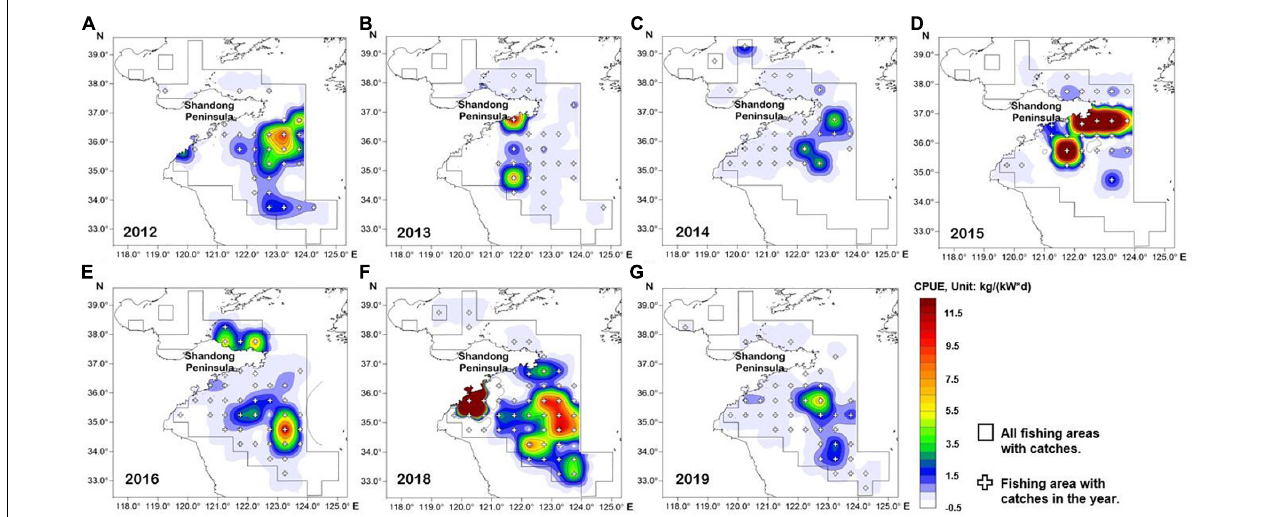
FIGURE 2 | Spatial distribution map of Lophius litulon abundance by fishing area and year (except 2017). (A) 2012; (B) 2013; (C) 2014; (D) 2015; (E) 2016; (F) 2018; (G) 2019.